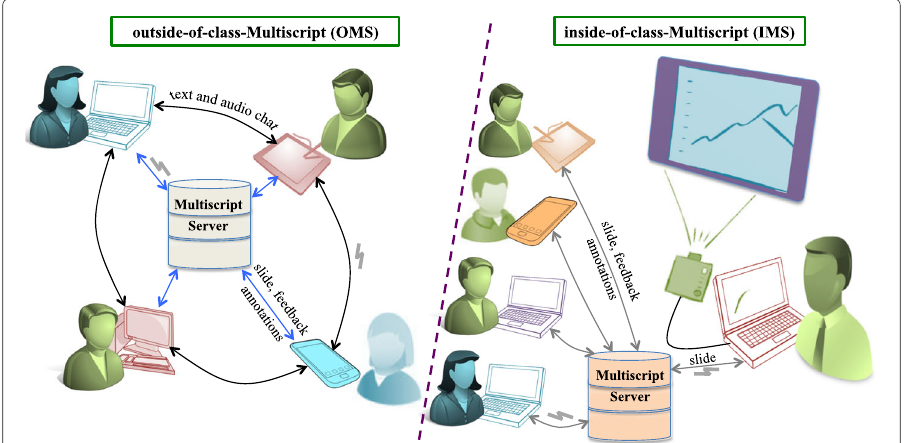
Fig. 1 Illustration of two collaboration platforms (OMS and IMS) of proposed Multiscript (MS) platform – the left and the right part illustrate the OMS and IMS approaches